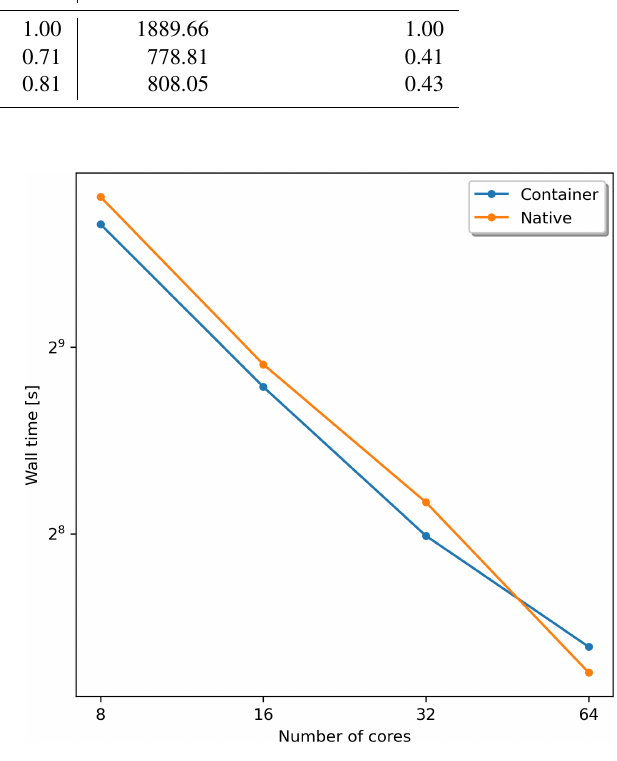
Figure 4. Performance and scalability of the containerized SHiELD (with Singularity), compared to those of the native SHiELD. Results are from 24h global–nest